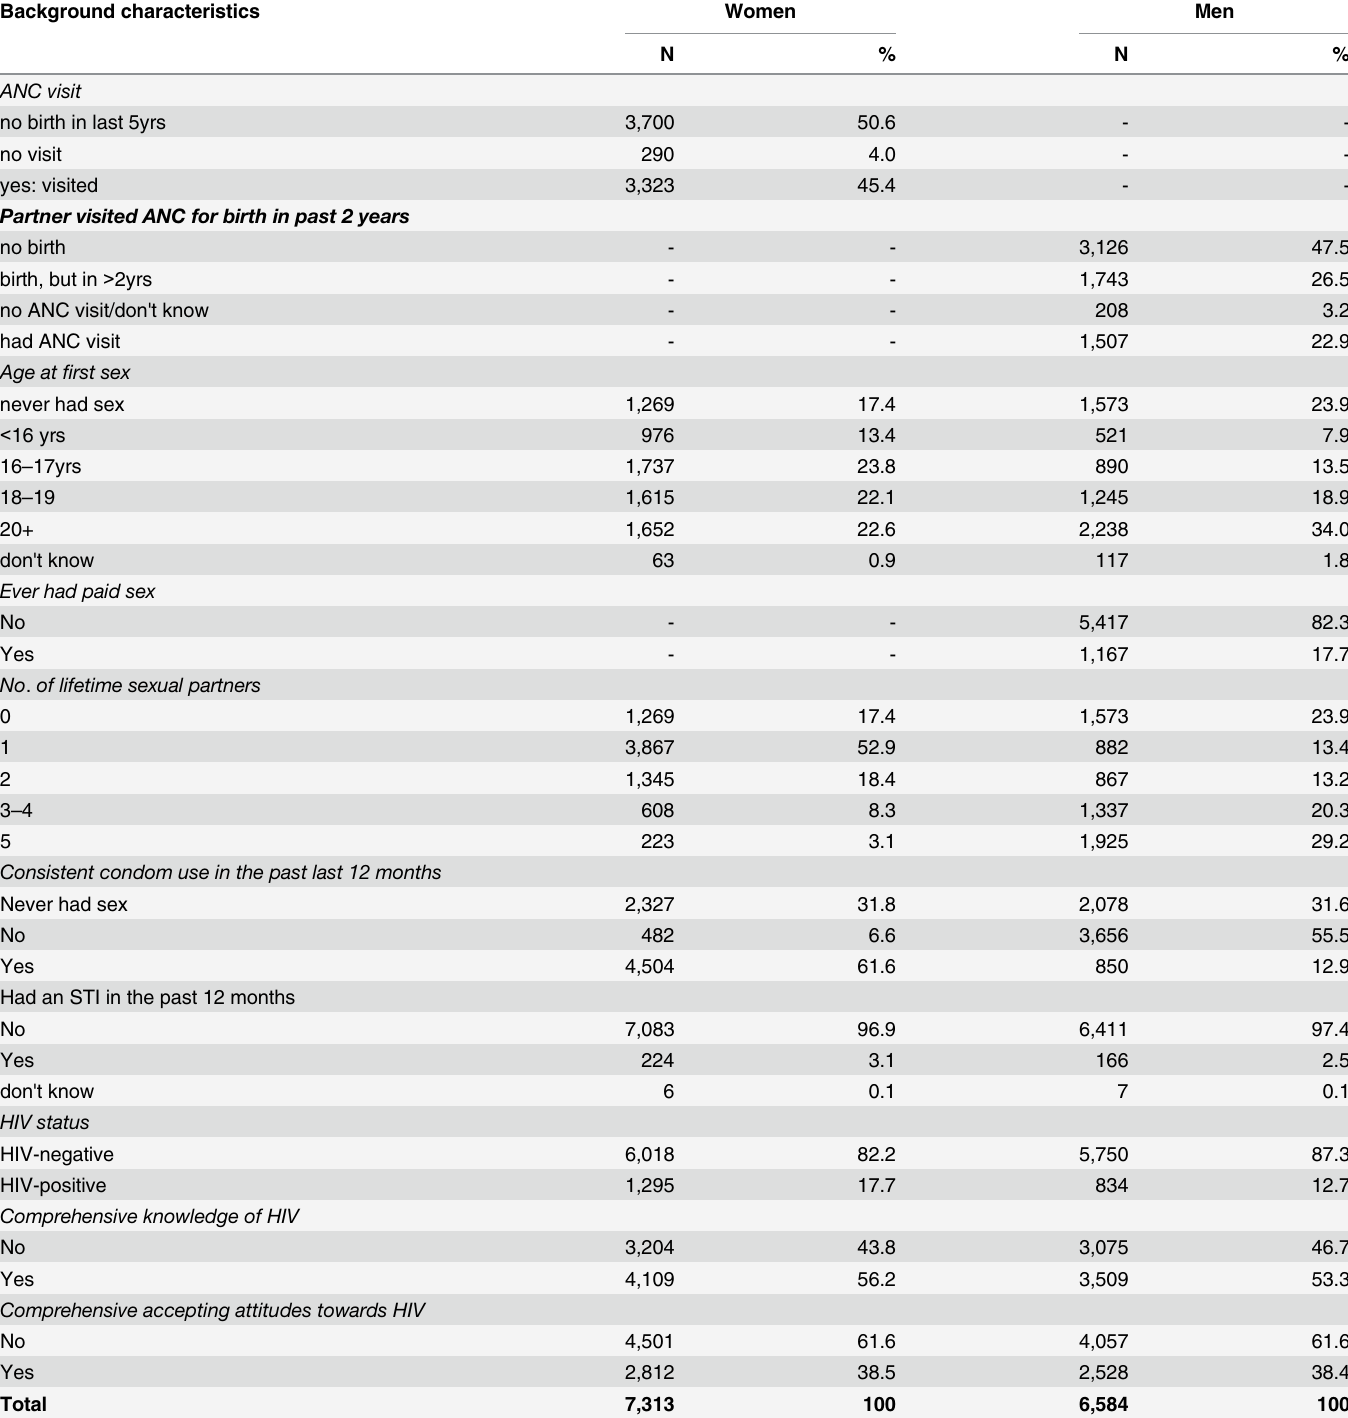
NB: Weighted numbers and percentages in the table above may not always add up to the totals shown in the last row of the table because of rounding-off